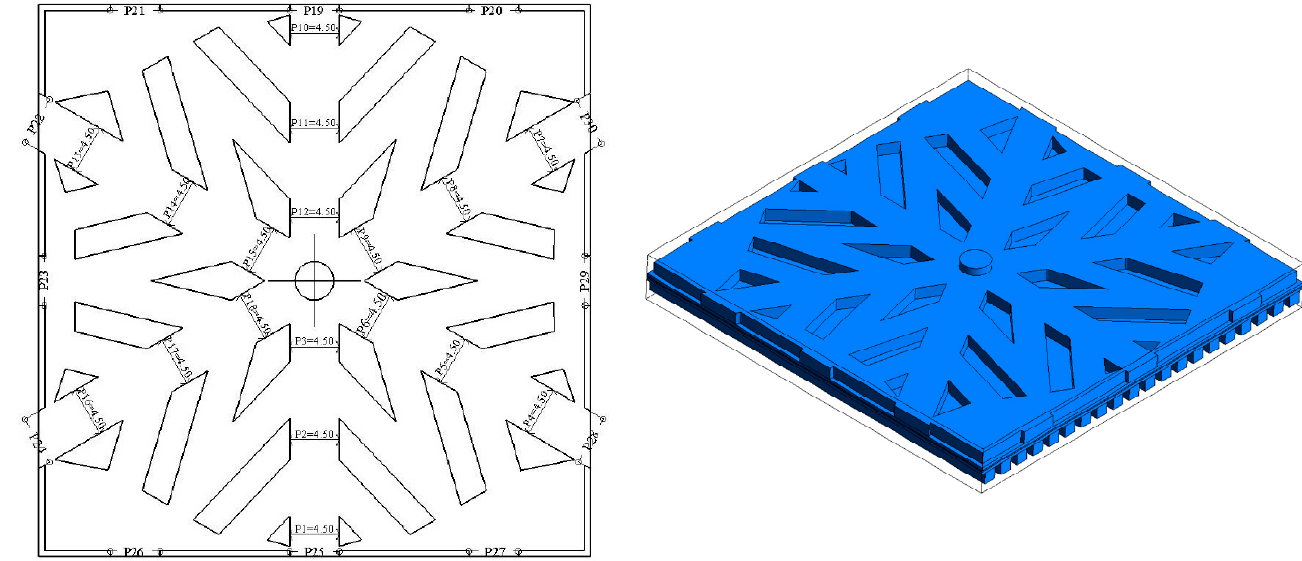
Figure 1. Snowflake bionic flow channel design.